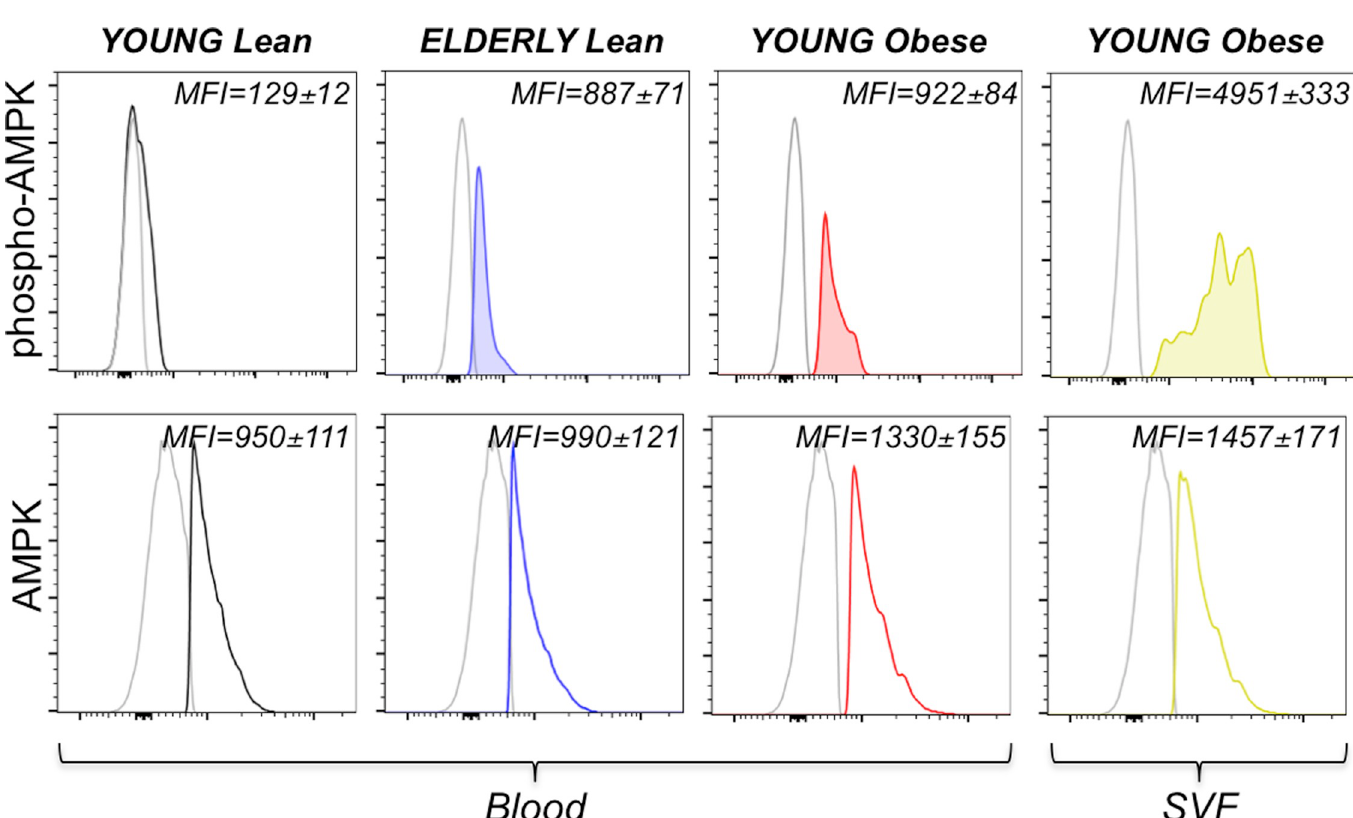
Fig 11. Effects of aging and obesity on AMPK. PBMC and SVF were from the same 4 individuals in Fig 10. Results show phospho-AMPK ( top ) and total AMPK ( bottom ), both measured by ic staining. Mean Fluorescence Intensity (MFI) ± SE is shown in each quadrant.